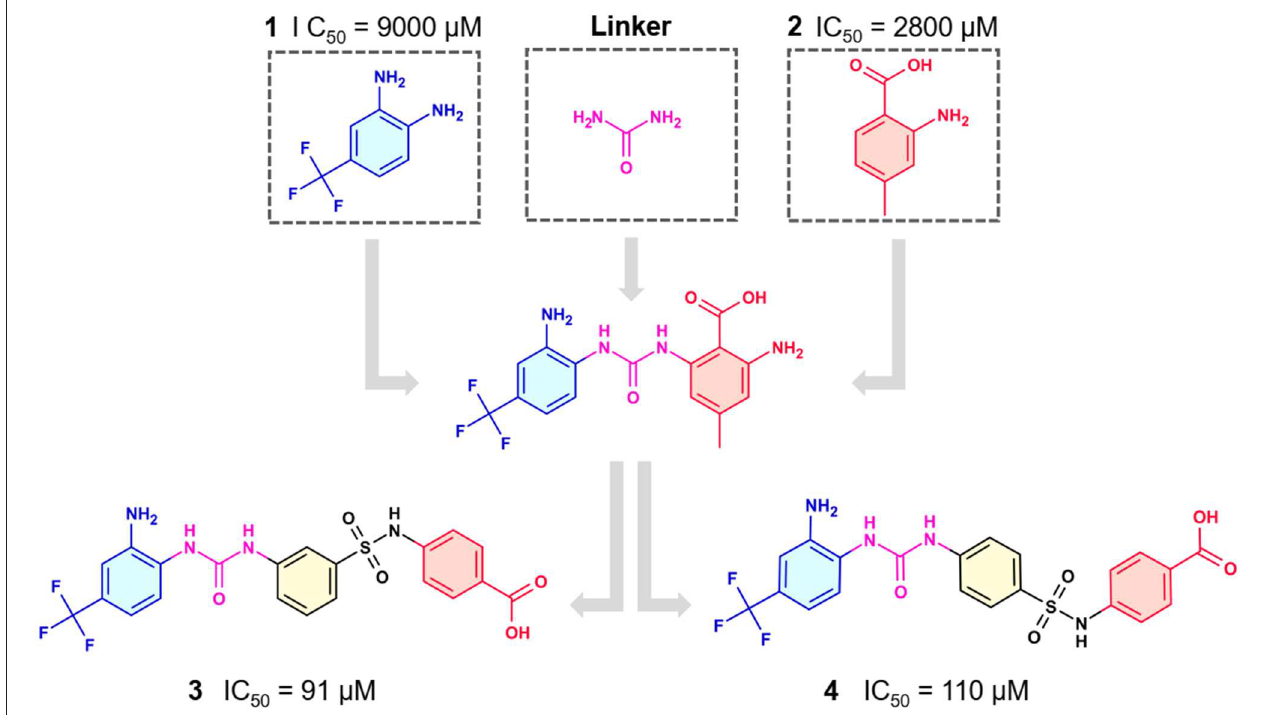
FIGURE 8 | Fragment optimization predecessors and products (Coutard et al., 2014; Benmansour et al., 2017). IC 50 value of 79 µ M and its most potent analog presented an IC 50 of 170 nM, representing a 470-fold improvement ( Table 3